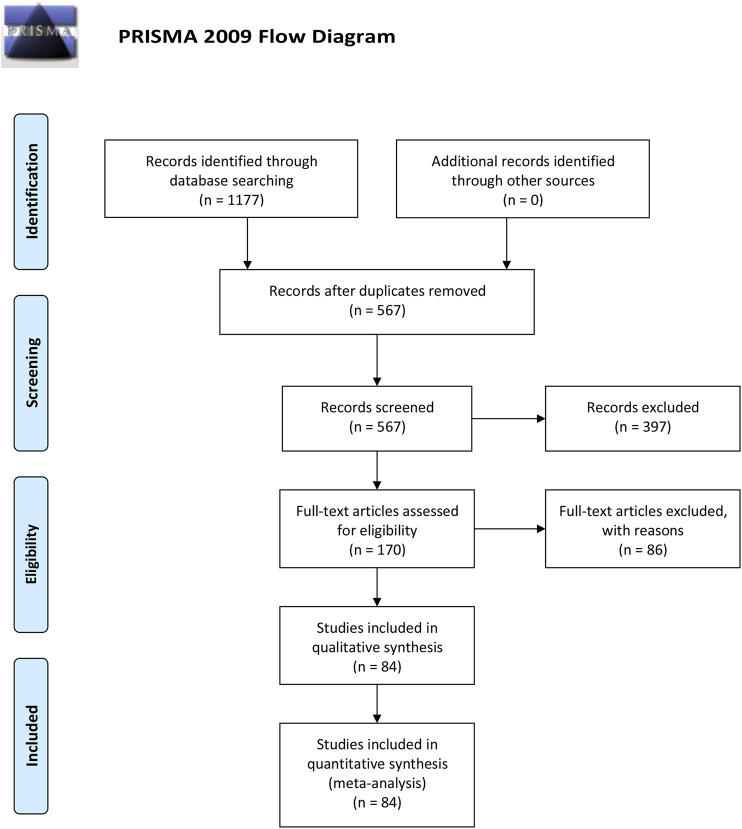
Prisma flow diagram.